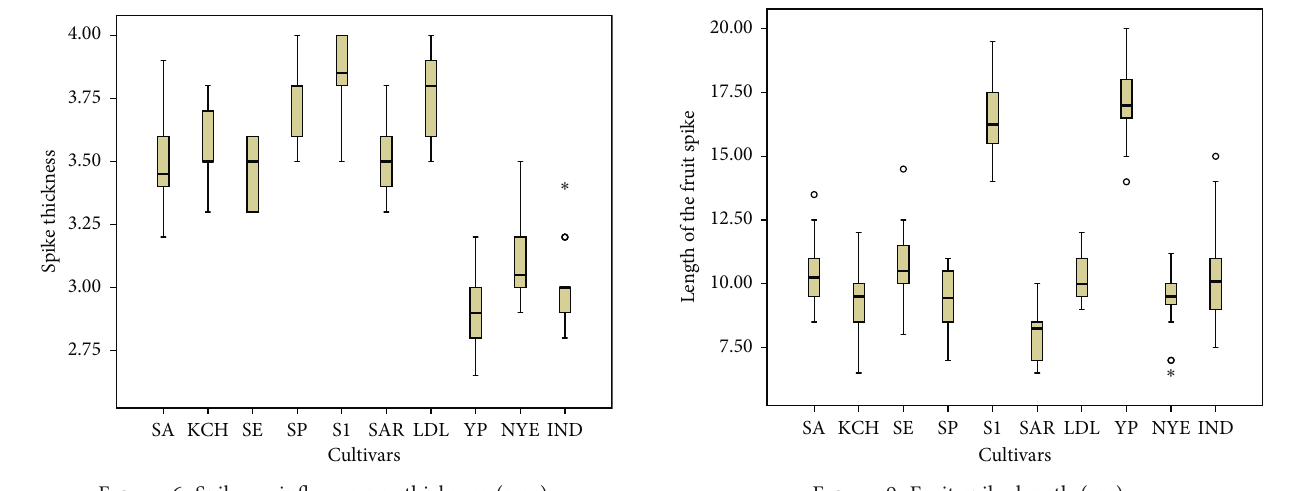
Figure 6: Spike or inflorescence thickness (mm).